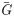
Results of the application of Virtual Twins with outcome Behaviour Rating Inventory of Executive Function (BRIEF).The ellipses in the figure represent the internal nodes containing the split variables, with below each ellipsis the corresponding split point. The upper ellipsis represents the root node corresponding to the complete group of children. The rectangles represent the leaves of the tree, that is, the final subgroups of children; each rectangle contains the sample size of the corresponding subgroup (N), and the mean estimated individual differential treatment effect (G¯). The leaves in which the estimated individual differential treatment effect exceeds the threshold c = 0.67) are represented by solid rectangles. Post-processing of the results suggest that there is an indication that the subgroups in these leaves have a significantly better outcome on BRIEF compared to the total group of children. Subgroup estimated treatment effect was 2.17 (d = 0.65). Total group estimated treatment effect was 0.65 (d = 0.20).